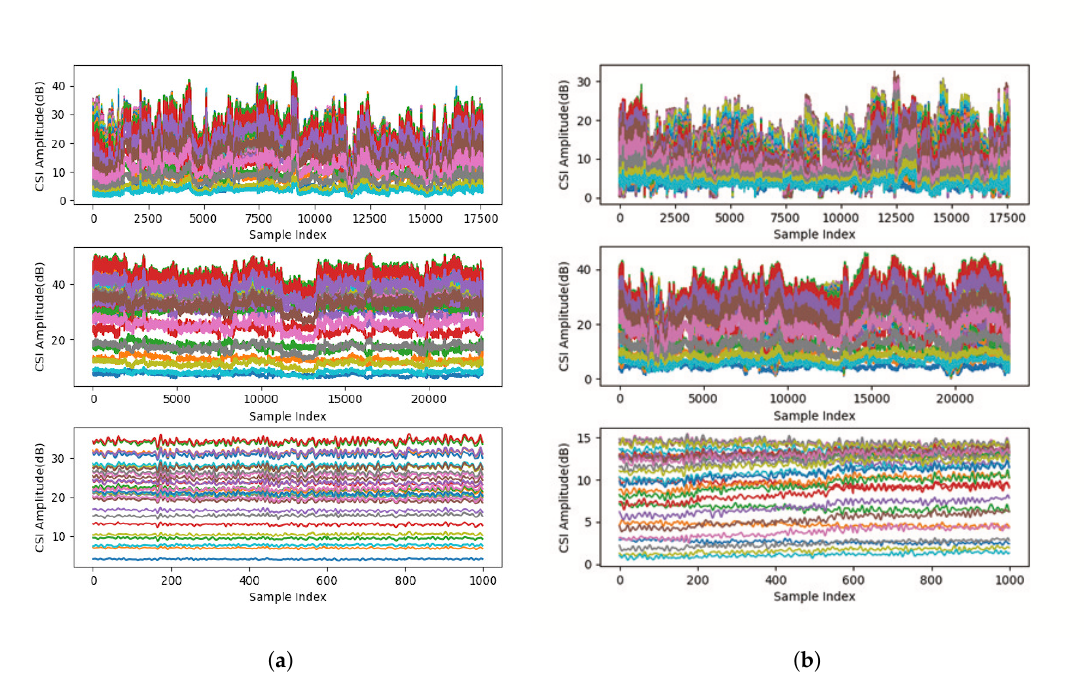
Figure 4. CSI amplitude of 30 subcarriers in shower, safe, and danger situations (from top to bottom). ( a ) CSI amplitude on one reception antenna, and ( b ) amplitude difference between two reception